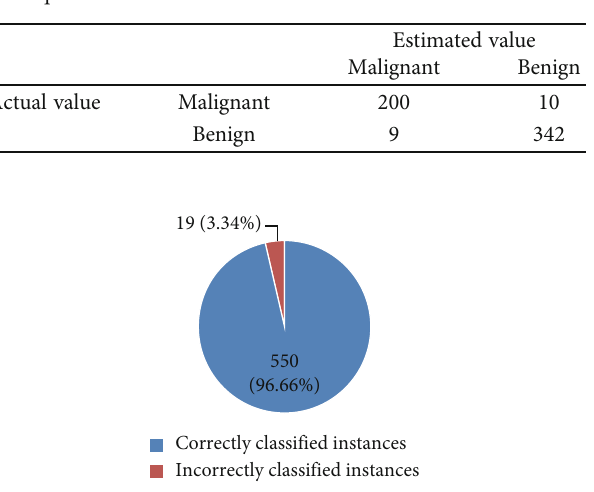
Figure 4: Accuracy and sensitivity information of the Naive Bayes technique. Table 3: Complexity matrix of the multilayer perceptron technique.